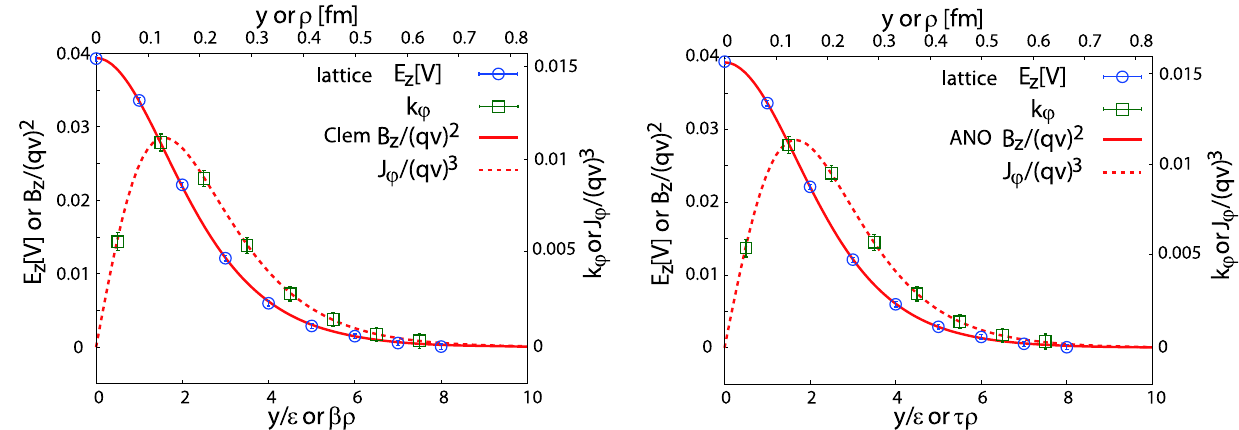
Fig. 7 The fitting results: (right panel) the approximated method based on the Clem ansatz including both the flux and magnetic current (70), (left panel) the new method (78) by solving the field equations of the ANO vortex with a unit winding number